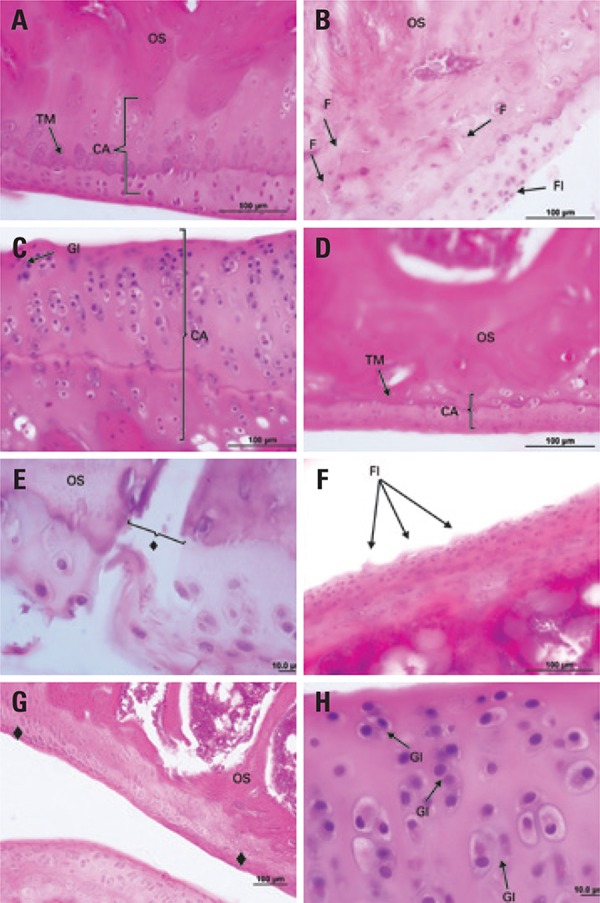
Fotomicrografias da cartilagem articular superior da tíbia direita de ratas, G1 (A), G2 (B), G3 (C), G4 (D), G5 (E e F) e G6 (G e H); corte frontal; coloração em hematoxilina e eosina. (A) Vista panorâmica da cartilagem articular (CA), com evidência para a tidemark (TM) e visualização de parte de osso subcondral (OS); (B) presença de fissuras (F), floculações (Fl) e desorganização tecidual; (C) aumento da espessura da cartilagem articular, hipercelularidade e aumento do número de grupos isógenos (GI); (D) diminuição da espessura da cartilagem articular e organização celular normal; (E) perda da cartilagem articular (♦) com exposição de osso subcondral; (F) presença de floculações na superfície da cartilagem (FI); (G) recuperação da cartilagem articular (♦) com formação de pannus e presença de clones; (H) aumento da espessura da cartilagem articular, hipercelularidade e aumento de grupos isógenos